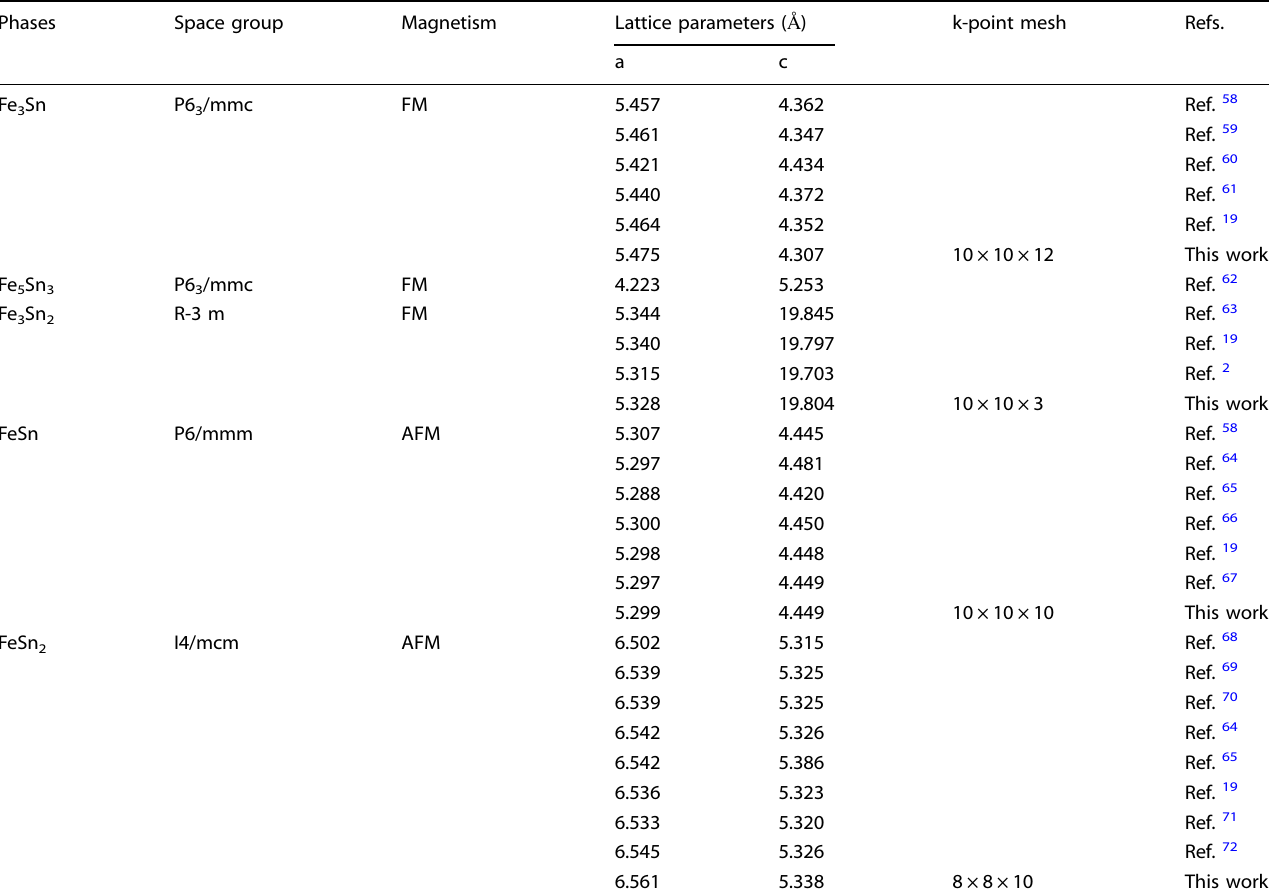
Table 1. Lattice parameters of intermetallics from fi rst-principles calculations compared with experimental values. Phases Space group